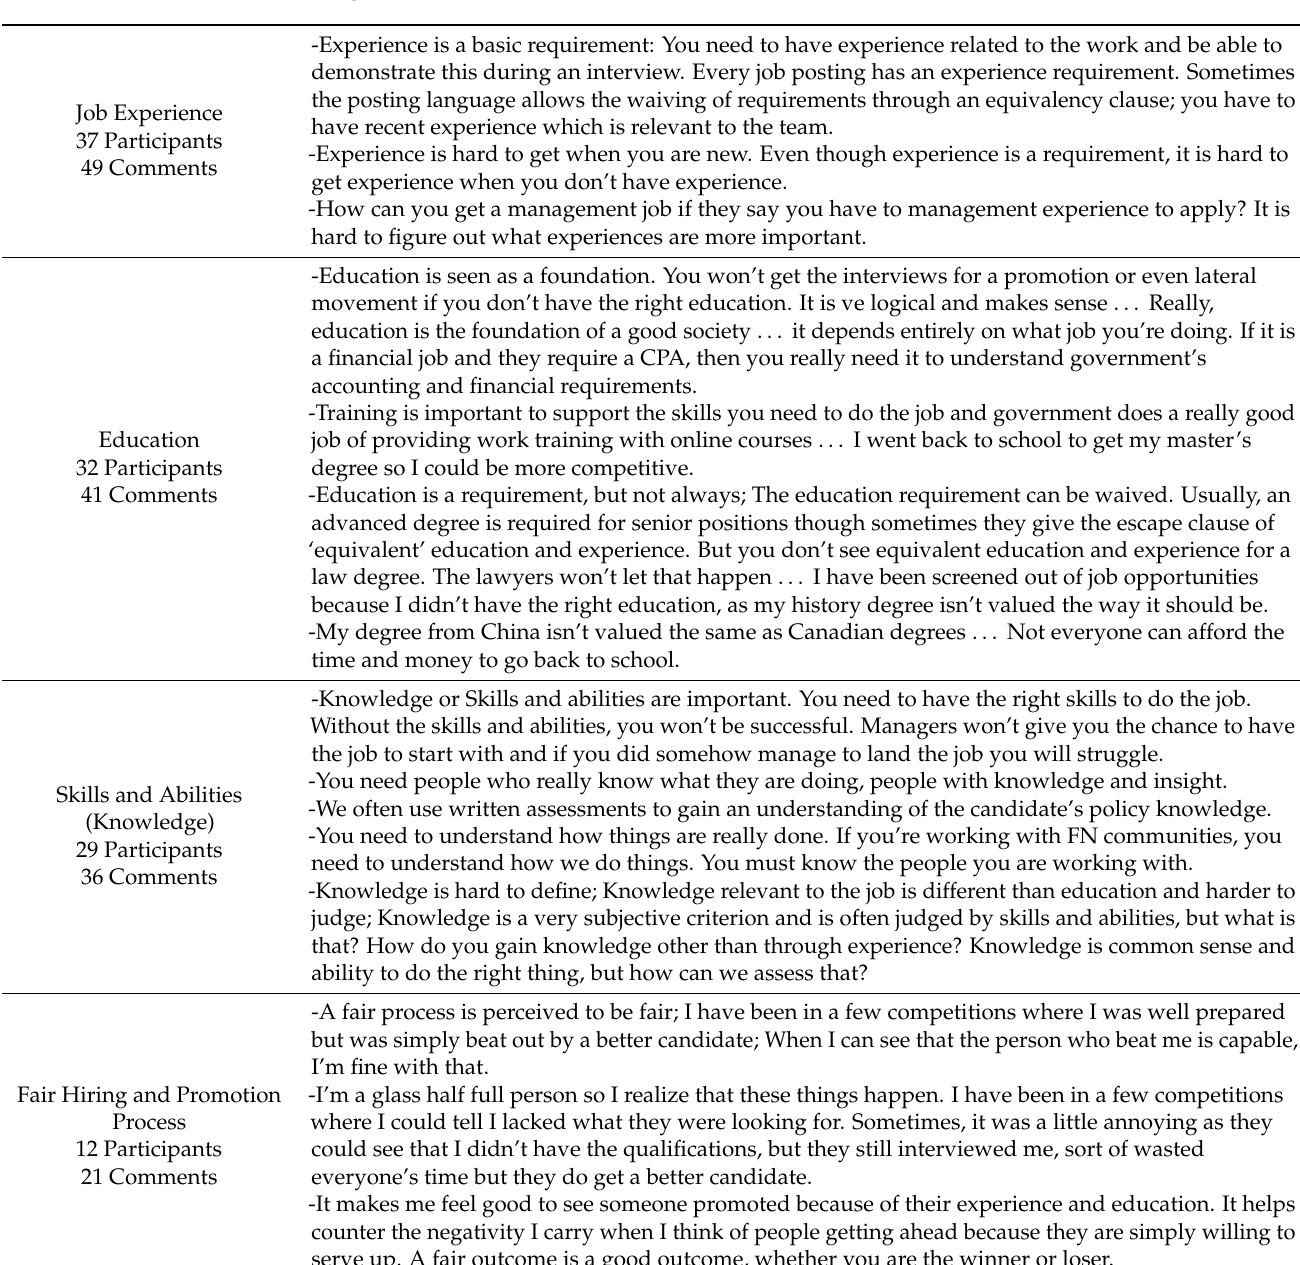
Table 1. Inability to demonstrate experience, abilities and education (52 Study Participants contribut- ing 147 Comments) N =